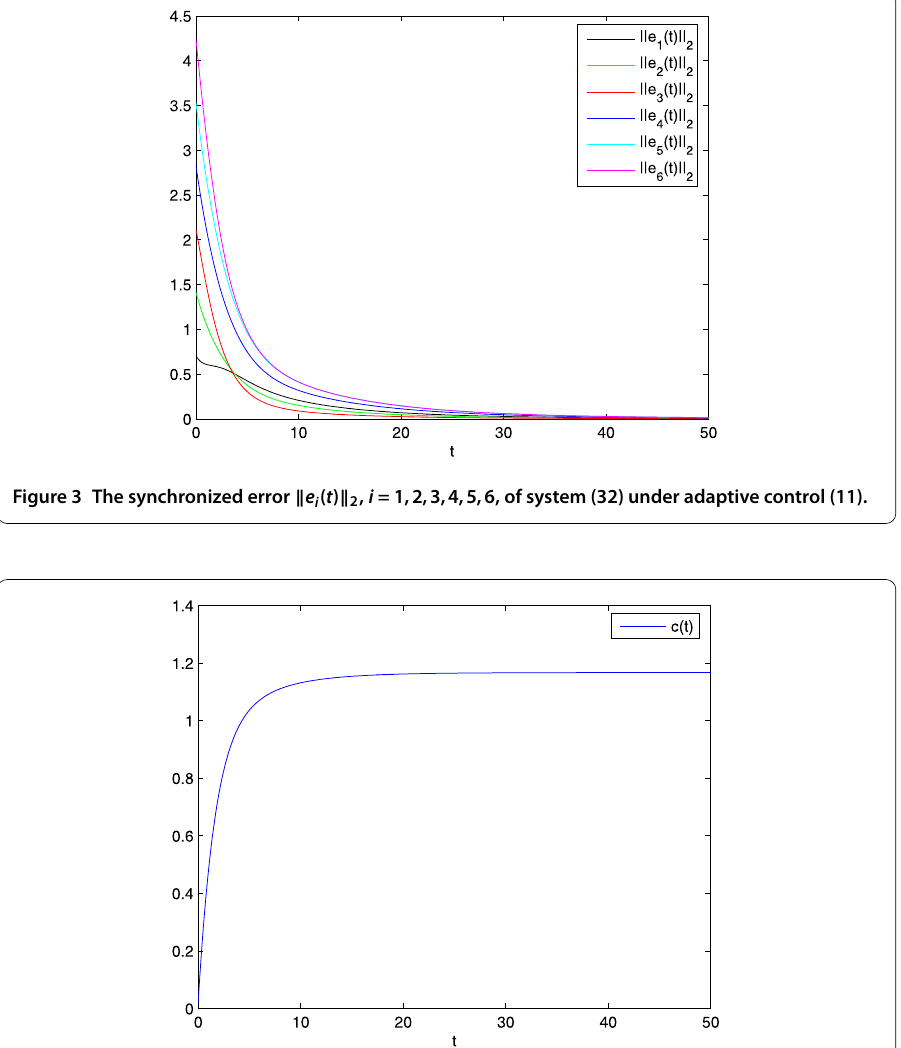
Figure 4 Adaptive coupling strength c (0) =